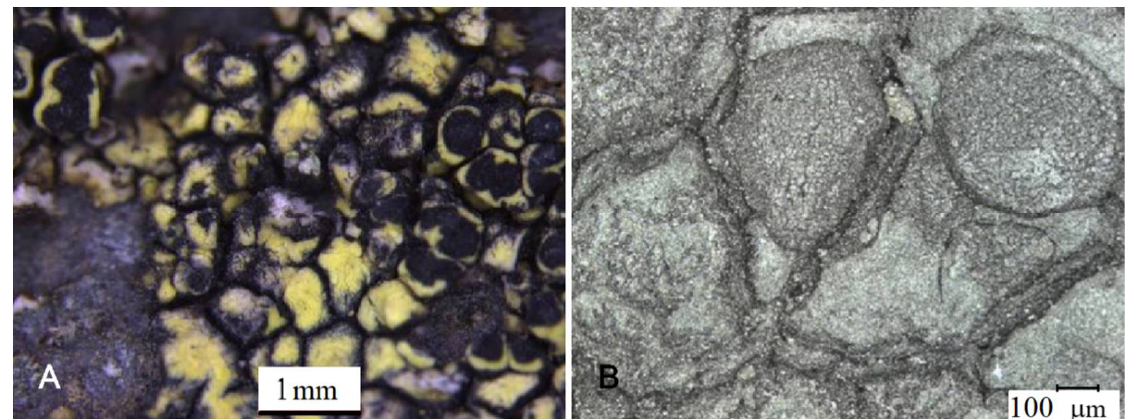
Figure 8. Dominant crustose lichen Dimelaena oreina on the rock surface: ( A ) thallus with fruiting bodies (light-microscope data); ( B ) fruiting bodies (apothecia) embedded into the solid substrate (laser-microscope data).